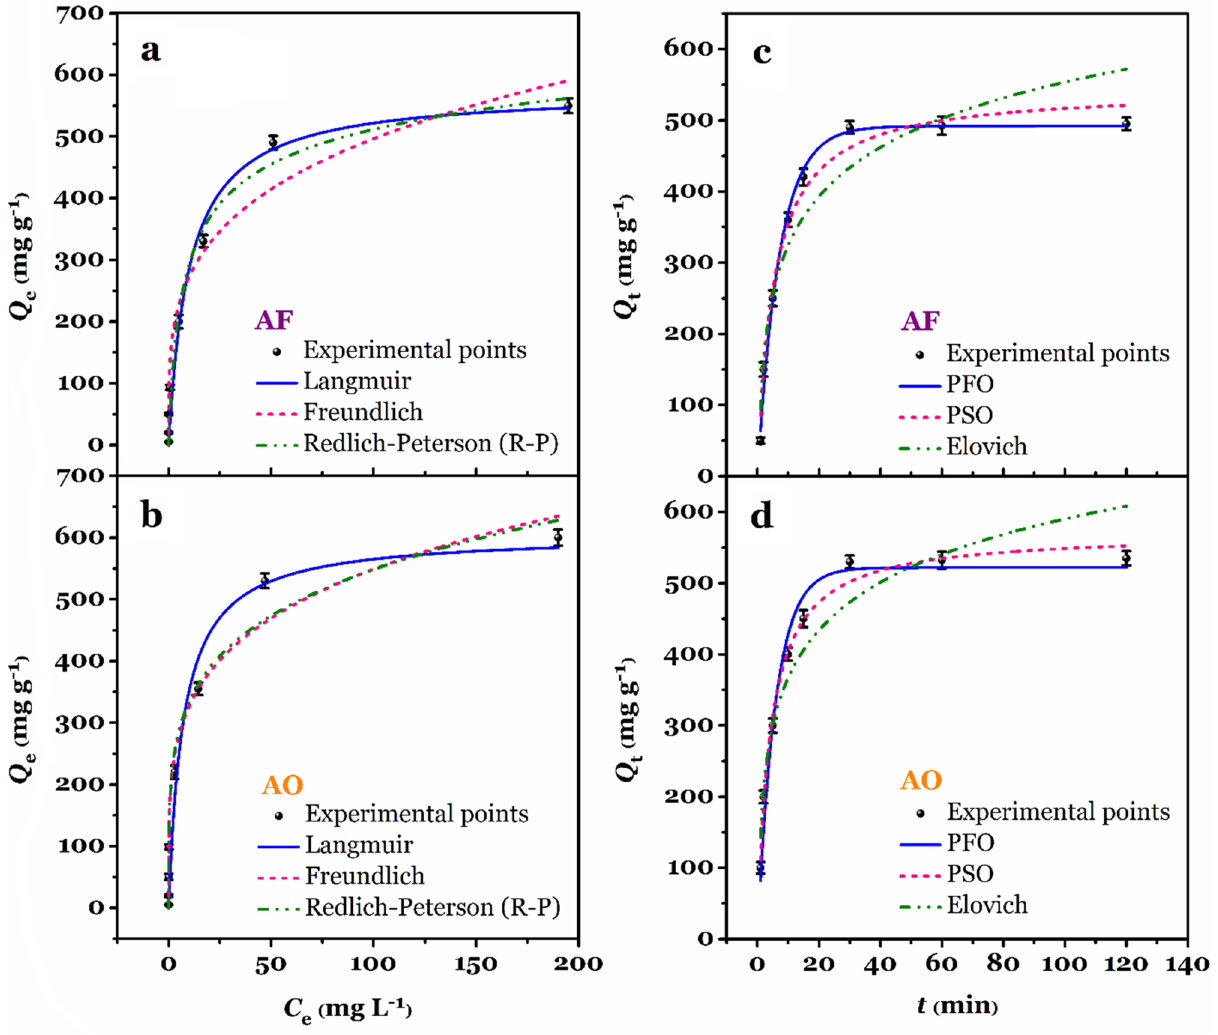
Figure 7. The effect of initial dye concentration on the adsorption capacity of AF ( a ) and AO ( b ) dyes and corresponding isotherm curves (pH = 3.0, W = 0.100 g L −1 , C i = 0.5–250 mg L −1 , t = 120 min, T = 25 °C, shaking speed = 180 rpm). The effect of time on the adsorption capacity of AF ( c ) and AO ( d ) dyes and corresponding kinetic curves (pH = 3.0, W = 0.100 g L −1 , C i = 100 mg L −1 , t = 1–120 min, T = 25 °C, shaking speed = 180 rpm).